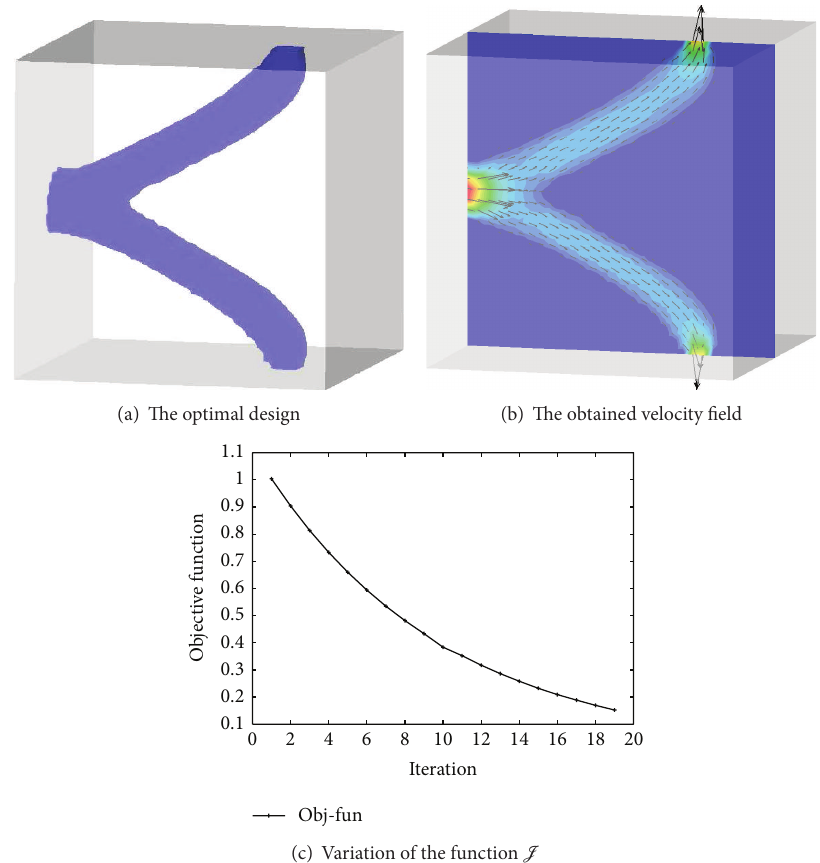
Figure 3: First case: cavity with one inlet and two